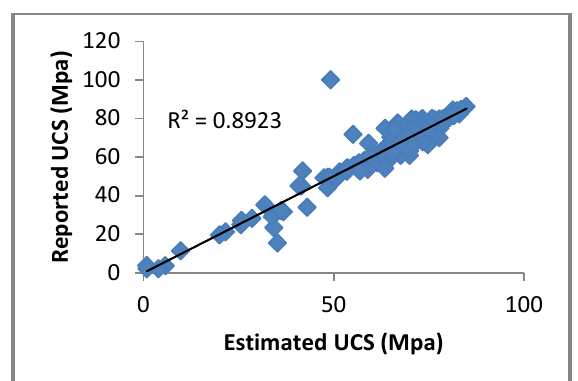
Figure 7. Correlation between experimental and predicted values from ANFIS in test data for uniaxial compressive strength